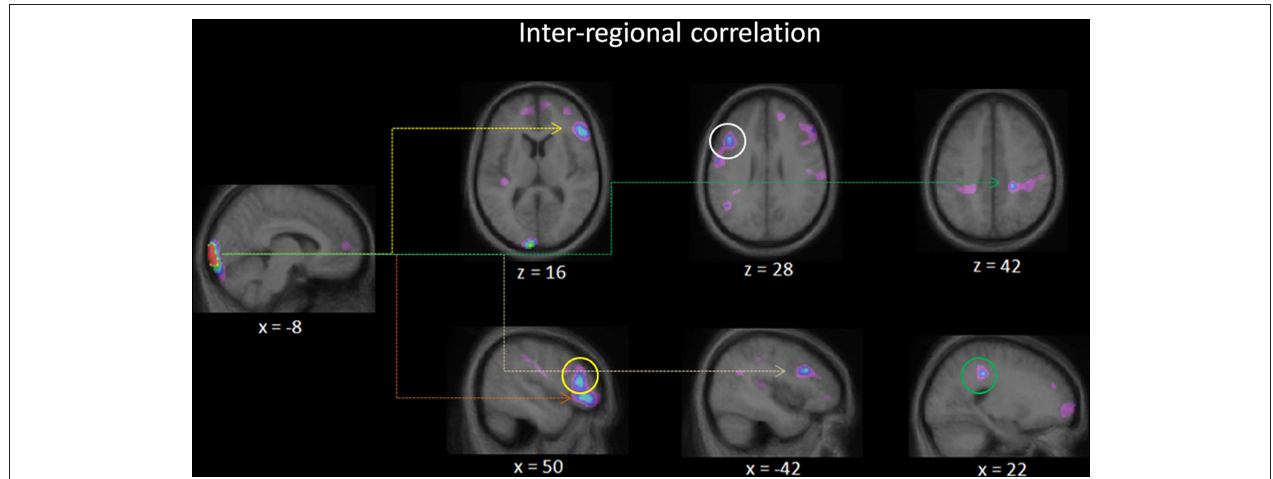
FigurE 6 | inter-regional correlation analysis. Illustrated here are the regions in which the activity covaried with that of the activity of a user defined seed region: the left lingual gyrus centered at tal. coord.: ( − 8, − 102, − 5). The seed point corresponds to the voxel whose activity most correlated with performance